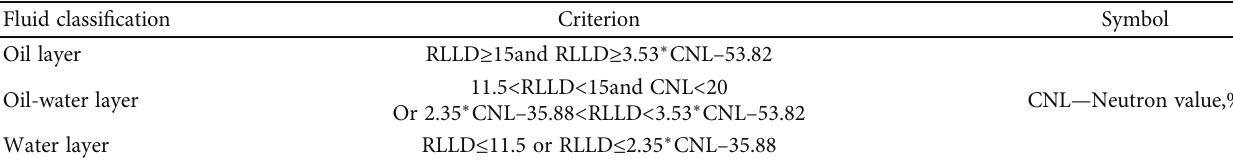
Table 8: Discrimination standard table.